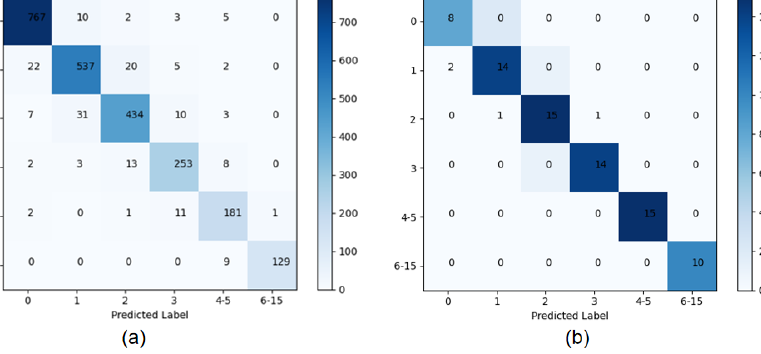
Figure 9. Confusion matrix for the prediction results of pain frames based on Parallel CNNs. ( a ) shows the confusion matrix for the predicted results of the whole test dataset, and ( b ) shows the confusion matrix for the predicted results of an 80-frame video.